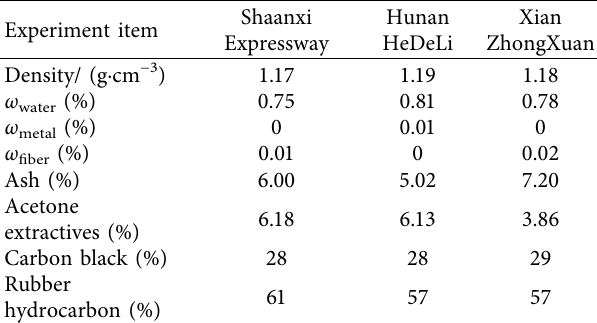
Table 2: Main technical indexes of